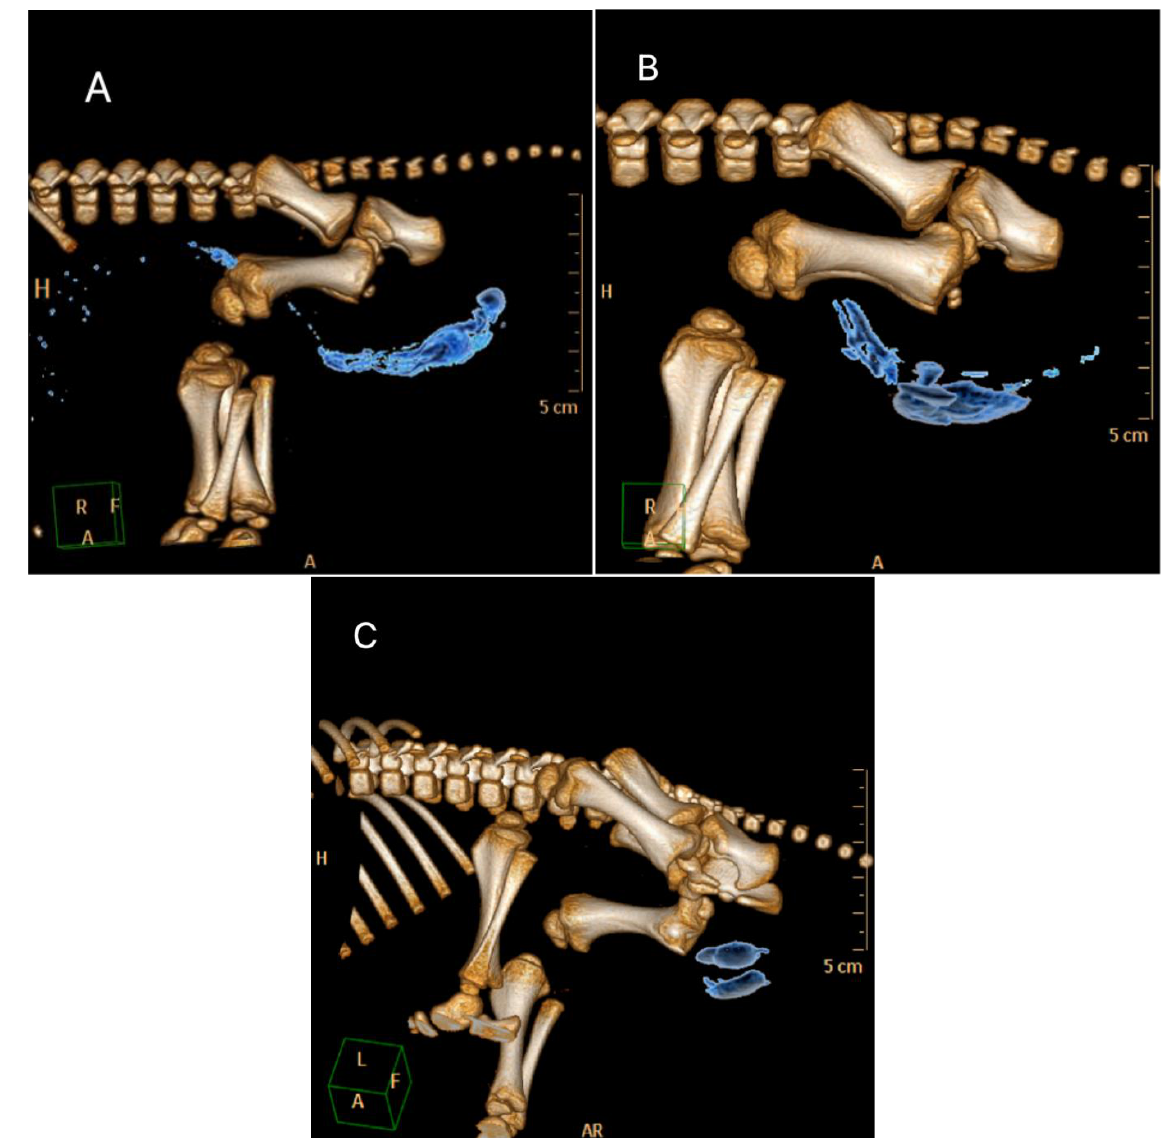
Figure 2. 3D-reconstruction of the CT-images showing the distribution of the surrogate after intratesticular ( A ), intrafunicular ( B ) and subscrotal ( C ) injection. Orange capital letters: A-anterior, L-left, R-right, H-head, F-feet.